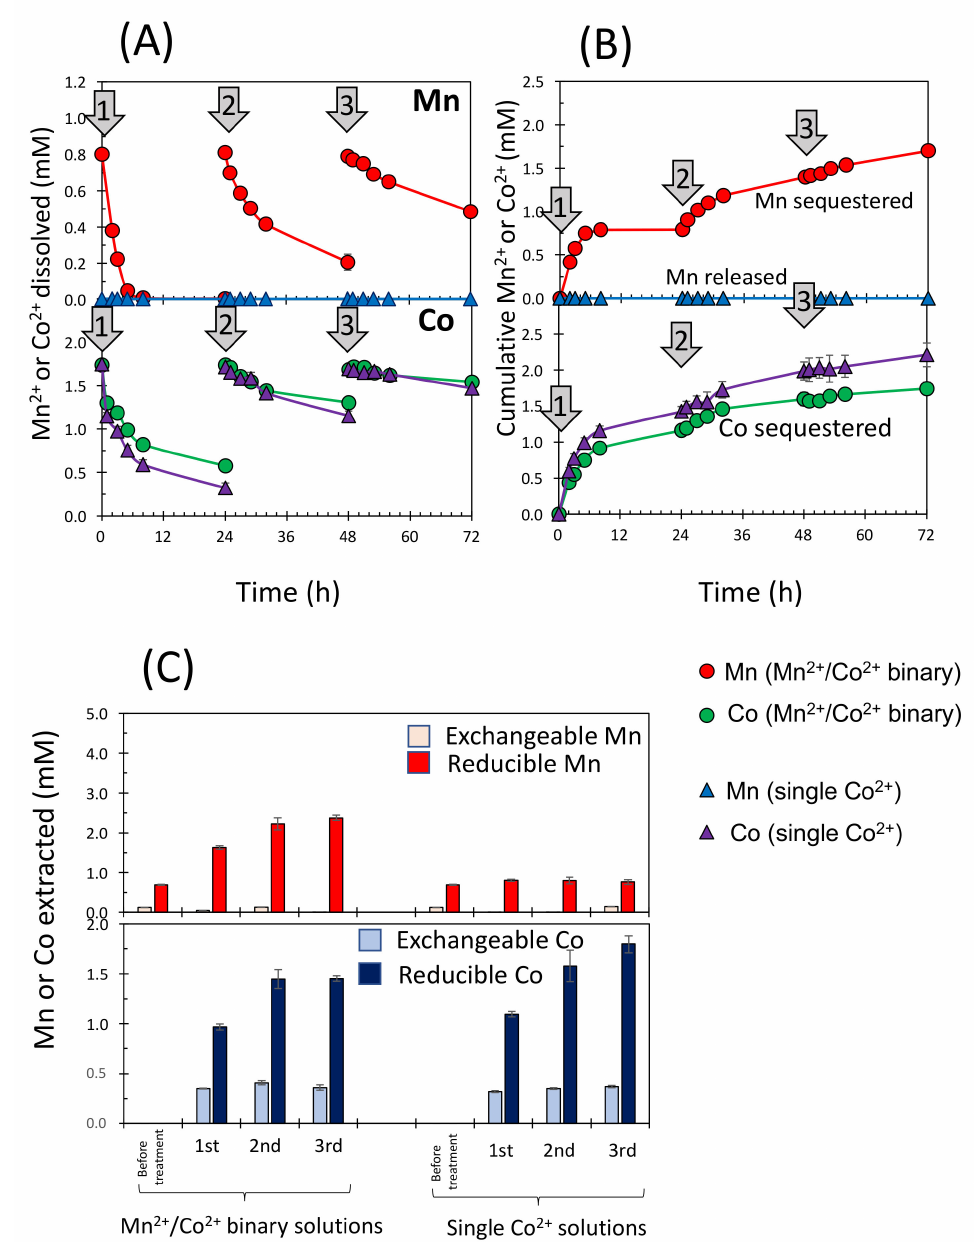
Figure 5. Repeated treatment experiments of newly formed biogenic manganese oxides (BMOs; 1 mM as Mn) under aerobic conditions at pH 7.0 (100 mM HEPES buffer) in 1.7 mM Co 2+ solutions with and without 0.8 mM exogenous Mn 2+ . ( A ) Changes in concentrations of dissolved Mn 2+ and Co 2+ . ( B ) Cumulative concentrations of sequestered or released Mn and sequestered Co, where circles represent Mn 2+ /Co 2+ binary systems and triangles represent single Co 2+ systems. ( C ) Mn and Co con- centrations in exchangeable and reducible phases for BMOs repeatedly treated in Mn 2+ /Co 2+ binary and single Co 2+ solutions. Bathing solutions were renewed every 24 h. Data are the mean ± standard deviation ( n =